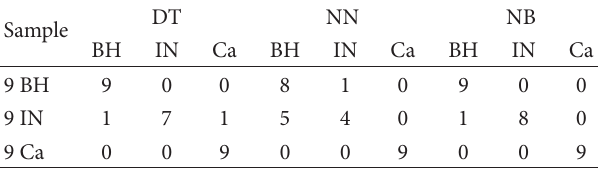
Table 5: Accuracy classifier (%) of ABC using selected features. Table 6: Confusion matrix of the ABC.